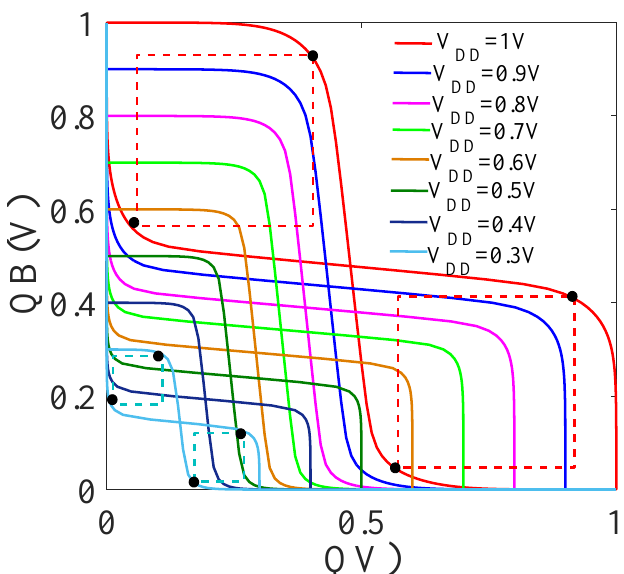
Figure 20. RNM butterfly curve for the proposed SRAM cell.